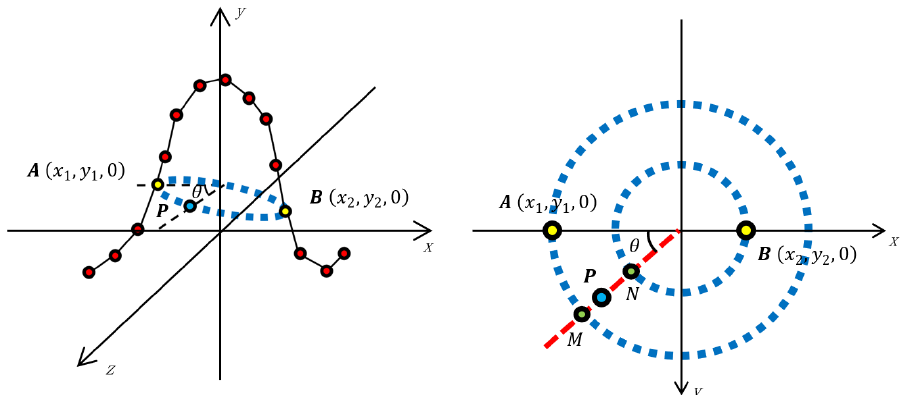
Figure 8. The method to calculate the coordinate of sampling point P . The left and right picture represents the 3D and 2D sketch map of the calculation method,